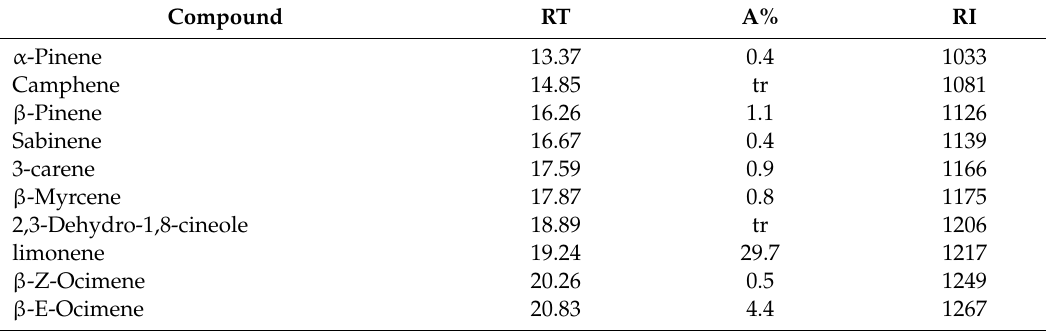
Table 1. Main compounds detected in the essential oil from pompia